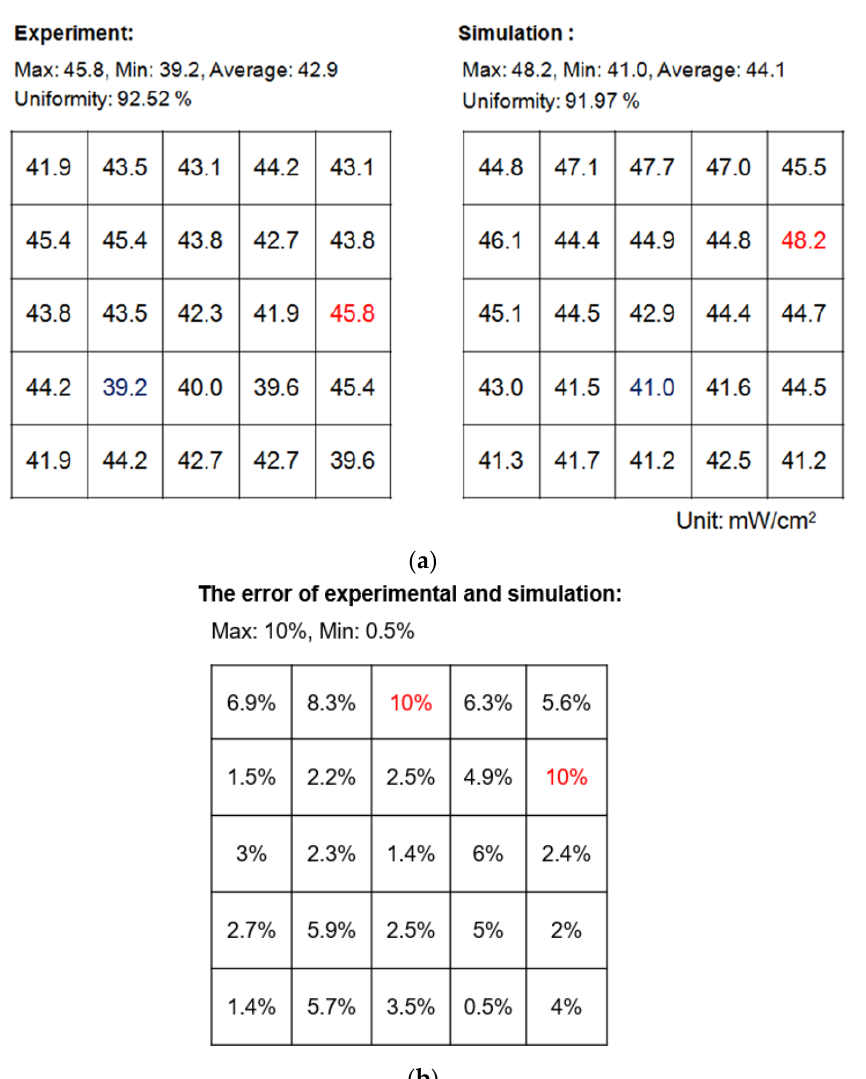
Figure 25. ( a ) The comparison of experimental and simulation of LED power adjustment type 1, ( b ) The error of experimental and simulation.